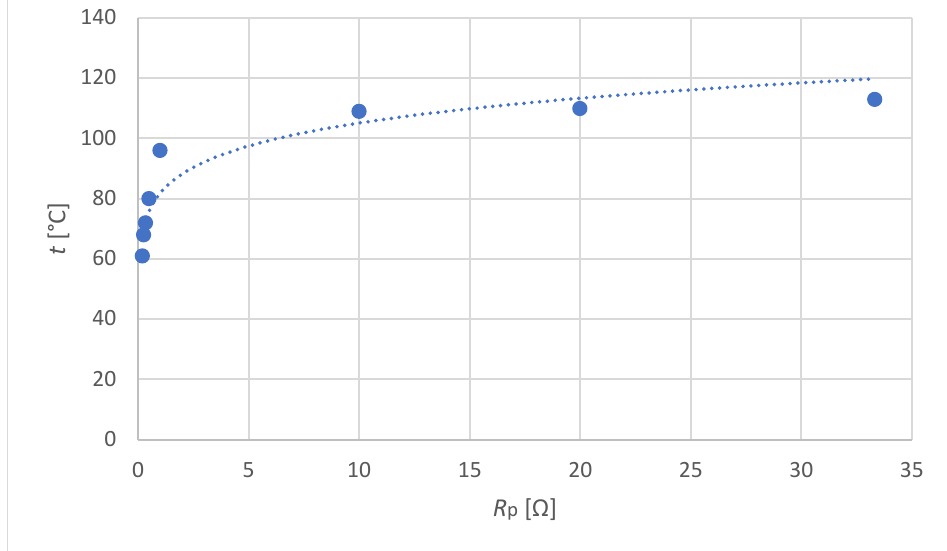
Figure 12. The dependence of the temperature of the DC connector on the value of its contact re- sistance.